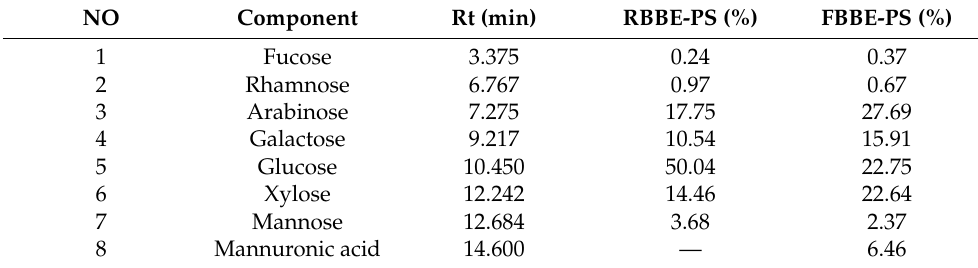
Table 2. Monosaccharide compositions of polysaccharides from unfermented (RBBE-PS) and fer- mented barley bran extract